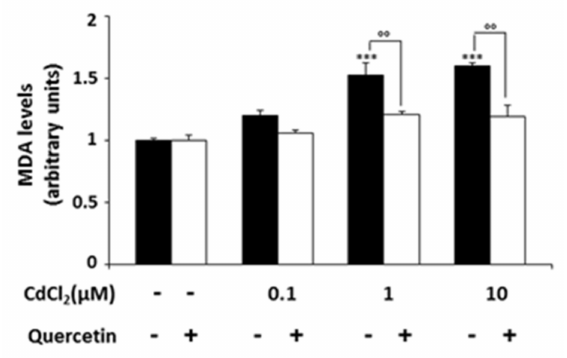
Figure 4. Lipid peroxidation in Nthy-ori-3-1 exposed to CdCl 2 and quercetin 5 µ M. Lipid peroxidation was evaluated by MDA assay (see Materials and Methods) after incubation of cells with quercetin and CdCl 2 alone or in combination for 24 h. MDA levels were expressed as fold of increase with respect to untreated cells considered arbitrarily as 1. The results are means ± SD of two independent experiments. Statistical analysis was performed using the Tukey–Kramer multiple comparisons test.